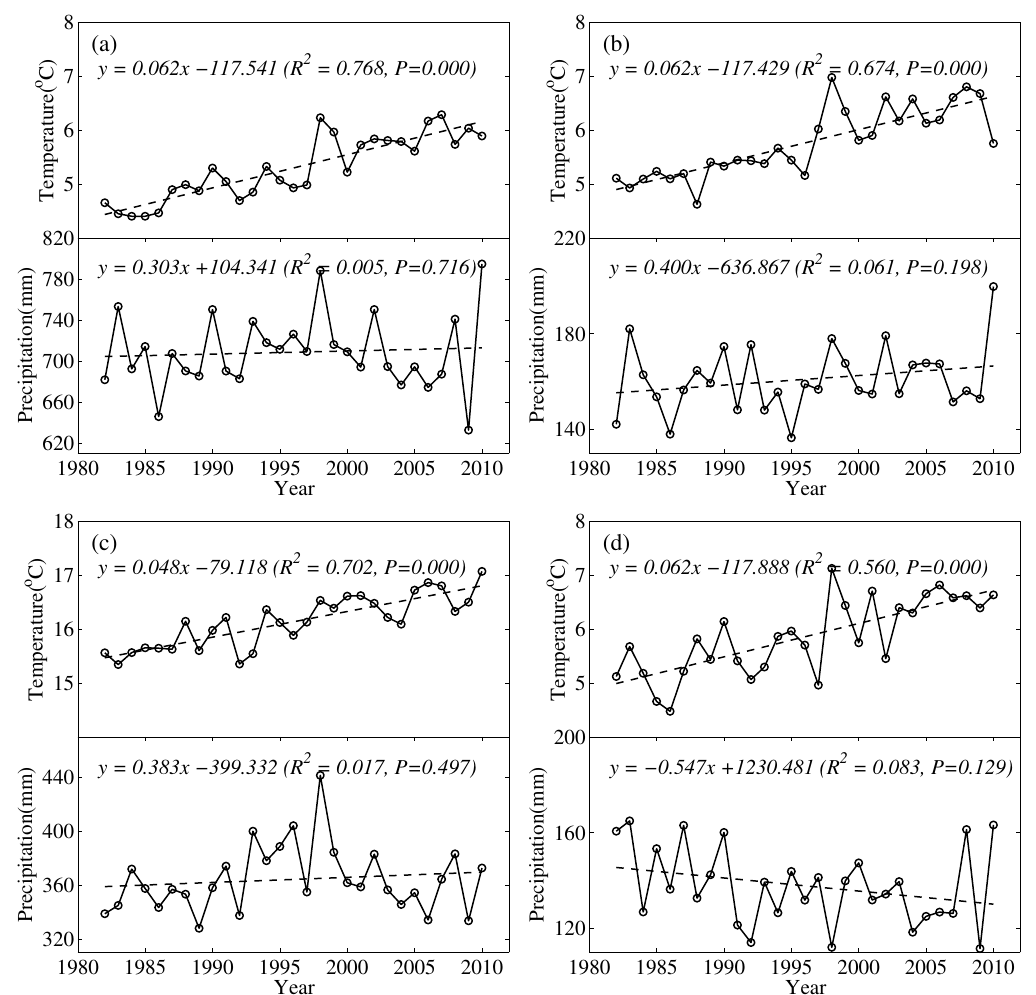
Figure 3. Interannual variation of mean temperature and precipitation in ( a ) growing season; ( b ) spring; ( c ) summer and ( d )autumn in China from 1982 to